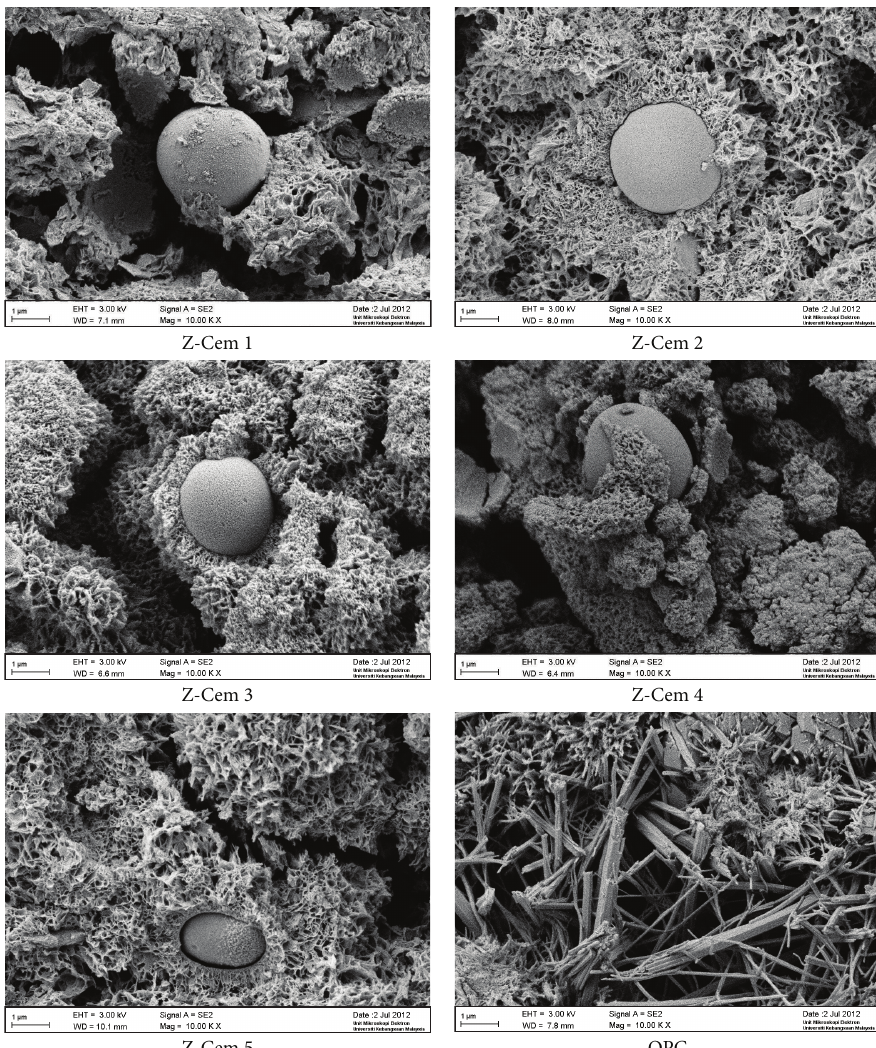
Figure 5: SEM images of OPC and Z-Cem mortars at 28 days of curing